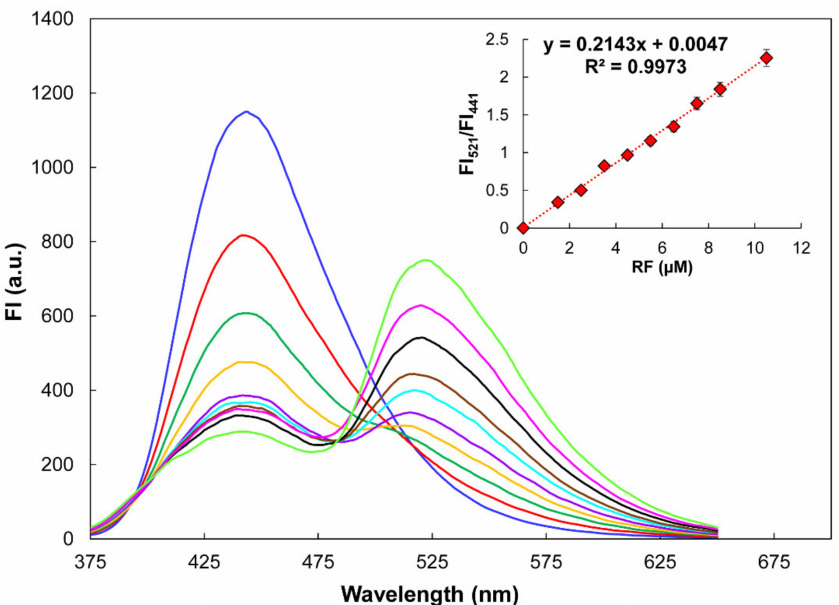
Figure 5. Variation in the fluorescence emission of the CDs–RF conjugate in the presence of different RF concentrations (0 µ M to 11 µ M). Inset: linear relationship between the fluorescence emission ratio (I 521 /I 441 ) of the CDs–RF conjugate and the RF